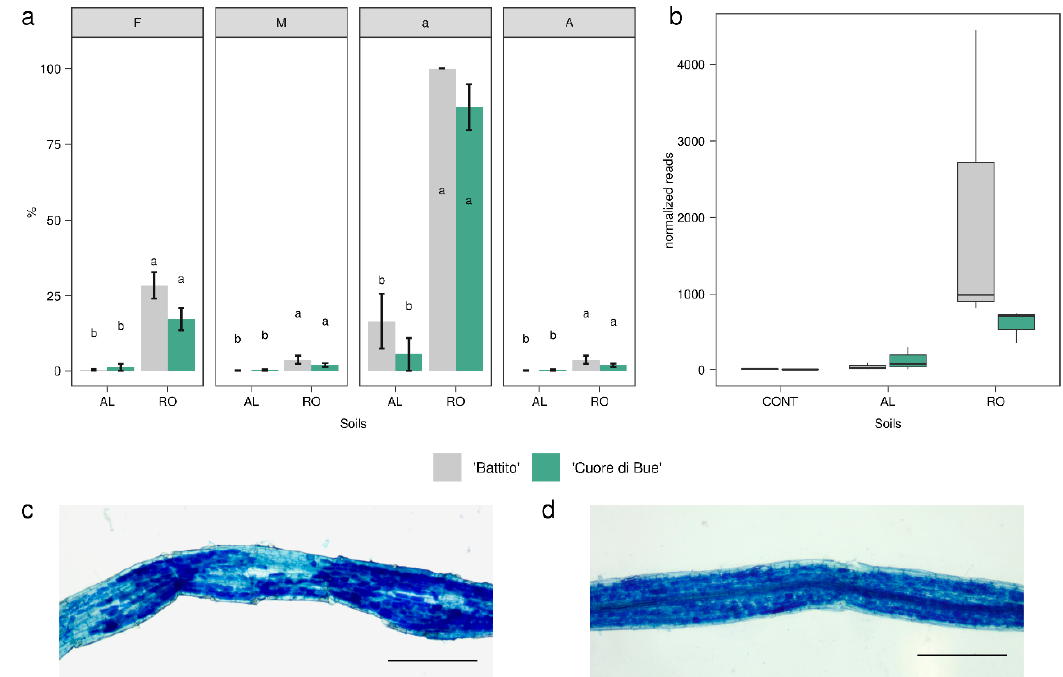
Figure 3. Mycorrhizal colonization of tomato roots growing in native soils and arbuscular mycorrhizal fungi (AMF) reads abundance. ( a ) Quantitative parameters of arbuscular mycorrhizal (AM) colonization of tomato roots (susceptible and resistant genotypes) growing in two di ff erent native soils: Mycorrhizal frequency (F), intensity of mycorrhization (M), presence of arbuscules within the mycorrhized segments (a), and the presence of arbuscules in the whole root apparatus (A) are plotted. Letters indicate significant di ff erences among means according to the Kruskall–Wallis test (Dunn’s post hoc test, p < 0.05). ( b ) Normalized reads relative abundances assigned to phylum Glomeromycotina in the meta-transcriptome analysis. ( c , d ). Micrographs showing AMF colonization in tomato roots from AL ( c ) and RO ( d ) natural soils. Scale bars correspond to 30 µ m in ( e ) and to 25 µ m in ( f ).